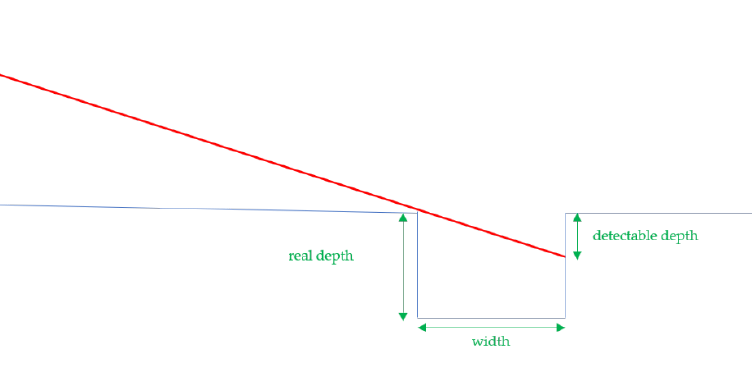
Figure 7. Detectable depth with beams pointing away.